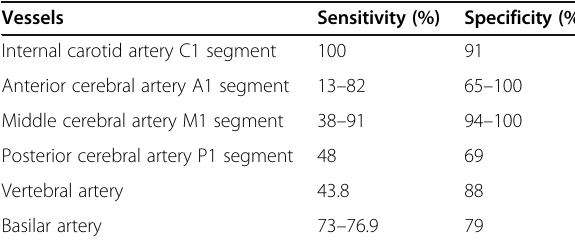
Table 3 Ranges of sensitivity and specificity of transcranial Doppler ultrasonography to detect vasospasm in different arteries [5]